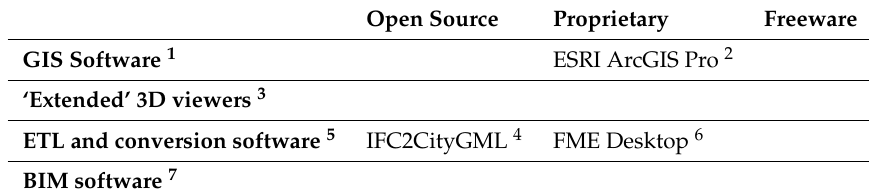
Table 8. Software tested for conversions from IFC to CityGML (Task 4).